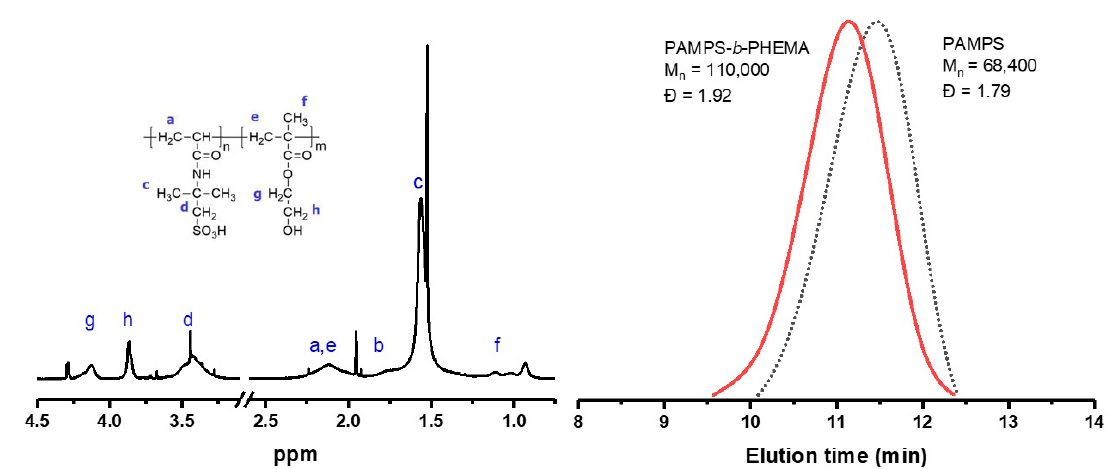
Figure 6. 1 H-NMR (D 2 O) y GPC elugram of poly(2-acryloamido-2-methylpropanesulfonic Figure 6. 1 H–NMR (D 2 O) y GPC elugram of poly(2-acryloamido-2-methylpropanesulfonic acid)- b - acid)- b -poly(2-hydroxyethylmethacrylate) (PAMPS- b -PHEMA) catalyzed by [Ru( o -C 6 H 4 -2-py) poly(2-hydroxyethylmethacrylate) (PAMPS- b -PHEMA) catalyzed by [Ru(o-C 6 H 4 -2- (phen)(MeCN) 2 ]PF 6 . py)(phen)(MeCN) 2 ]PF 6 .